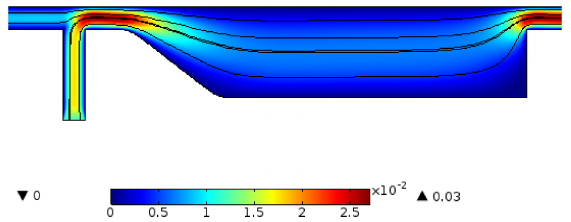
Figure 11. Velocity field within the separator geometry: at the cross section of two inlet flows, the velocity reaches its maximum. The streamlines are also illustrated. For applicability of device for extensive cellular study, one must ensure that the shear rate within the channel does not violate the maximum allowable shear. Otherwise, the cell viability is critically